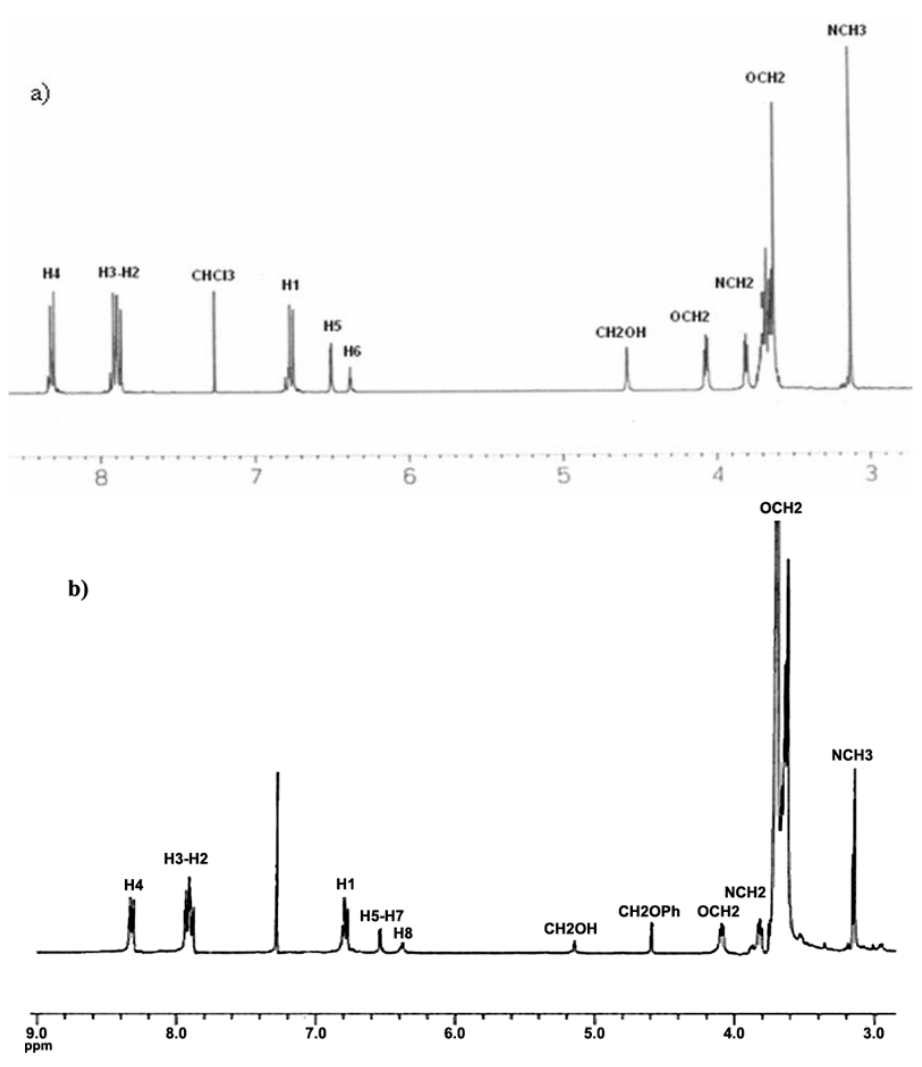
Figure 1. 1 H-NMR of: ( a ) First generation dendron 4G OH dendron 8G 2